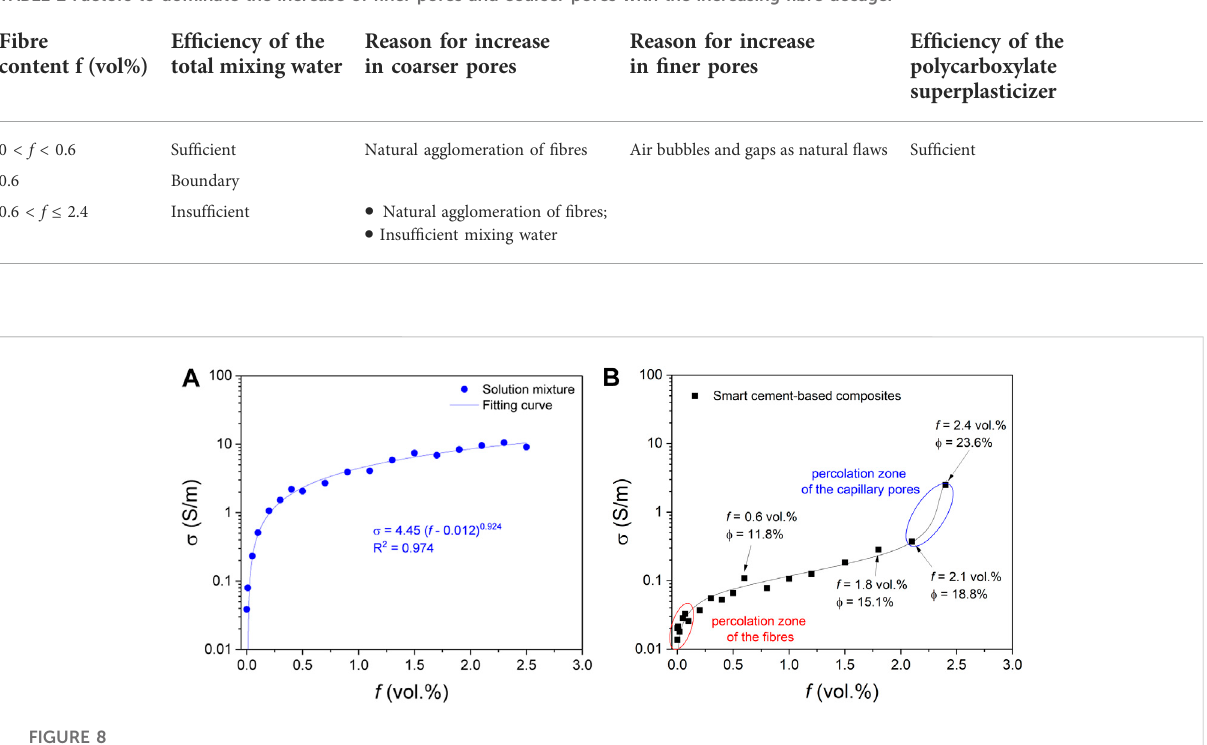
FIGURE 8 Developmentofbulkconductivity σ withtheincreasing fi brecontentfindifferentsubstrates (A) thesolutionmixture(withdilutedCHsolutionas a continuum substrate) (B) the smart cement-based composites (with water-saturated mortar matrix as an inhomogeneous